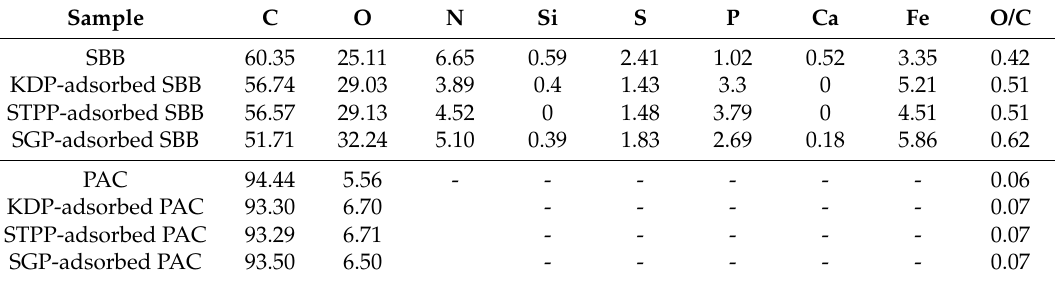
Table 1. Elemental compositions (Atomic %) and oxygen to carbon atomic ratios of sludge-based biochar(SBB) and powder activated carbon (PAC) before and after the phosphate adsorptions estimated by X-ray photoelectron spectroscopy (XPS).